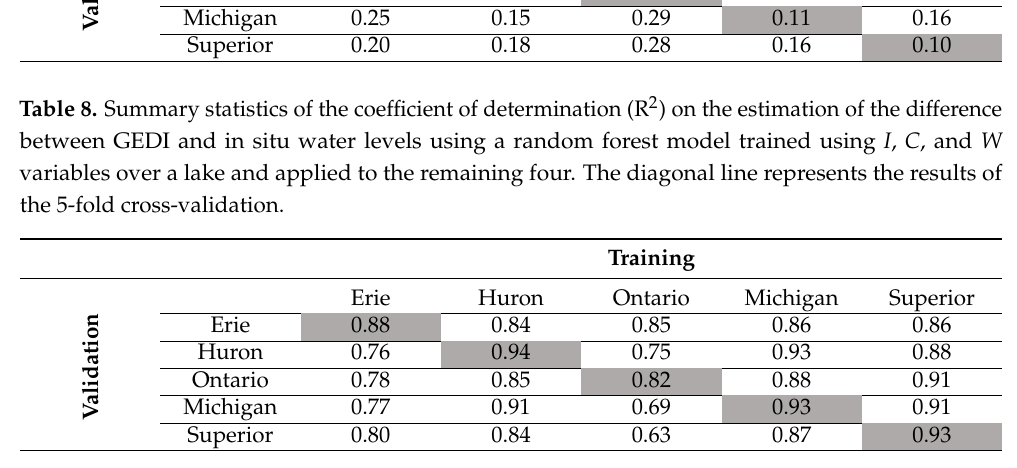
Table 7. Summary statistics of the RMSE on the estimation of water surface elevations using a random forest models trained using I , C , and W variables over a lake and applied to the remaining four. The diagonal line represents the results of the 5-fold cross-validation. Training Erie Huron Ontario Michigan